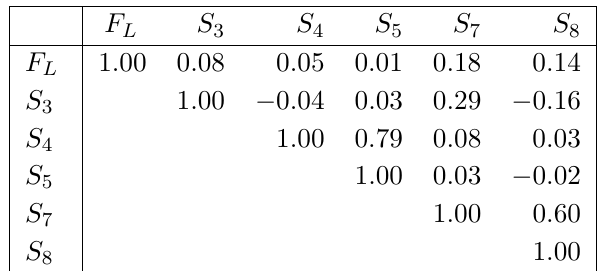
Statistical correlation matrix for the F [0 : 04 ; 4 : 0] GeV 2 .